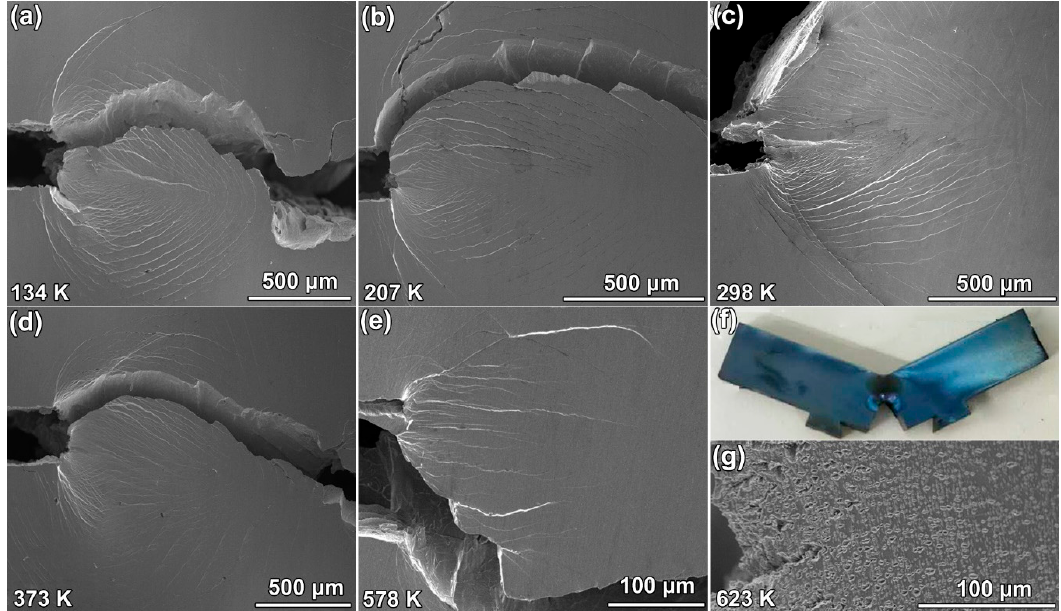
Figure 3. Side surface morphology of fractured specimens ( a – e ) fractured at 134, 207, 298, 373, and 578 K, respectively. The wide cuts on the left-hand side of the images are tips of fatigue pre-cracks. ( f ) The unfractured sample tested at 623 K. The blue color on the surface indicates oxidization. ( g ) SEM image of the region ahead of crack tip of the unfractured sample. A large void can be seen in the image.